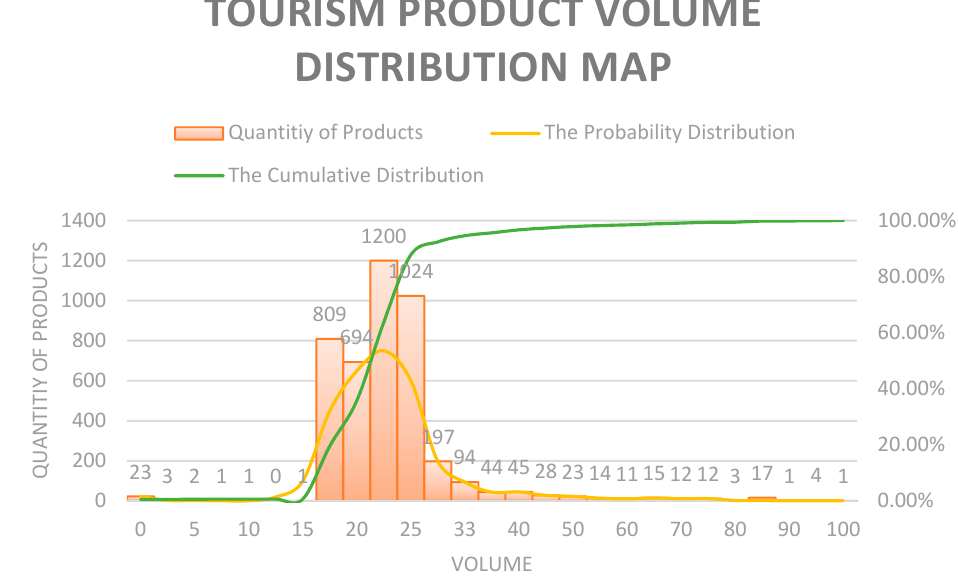
Figure 2. Tourism product volume distribution map.